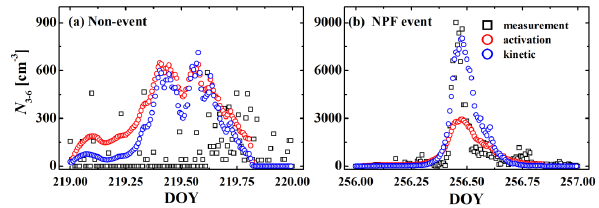
Fig. 3. Measured and modelled particle number concentrations in Figure 3. Measured and modelled particle number concentrations in the size range 3-6 nm ( N 3-6 ) for two selected 863 the size range 3–6nm ( N 3 − 6 ) for two selected days. (a) A non- days. (a) : a non-event day (August 6, day 219), (b) : NPF event day (September 12, day 256); Black square: 864 event day (6 August, day 219), (b) NPF event day (12 September, measurement, Red circle: modelled with activation nucleation mechanism, Blue circle: modelled with kinetic 865 day 256); black square: measurement, red circle: modelled with ac- nucleation mechanism. 866 tivation nucleation mechanism, blue circle: modelled with kinetic 867 nucleation mechanism. 868